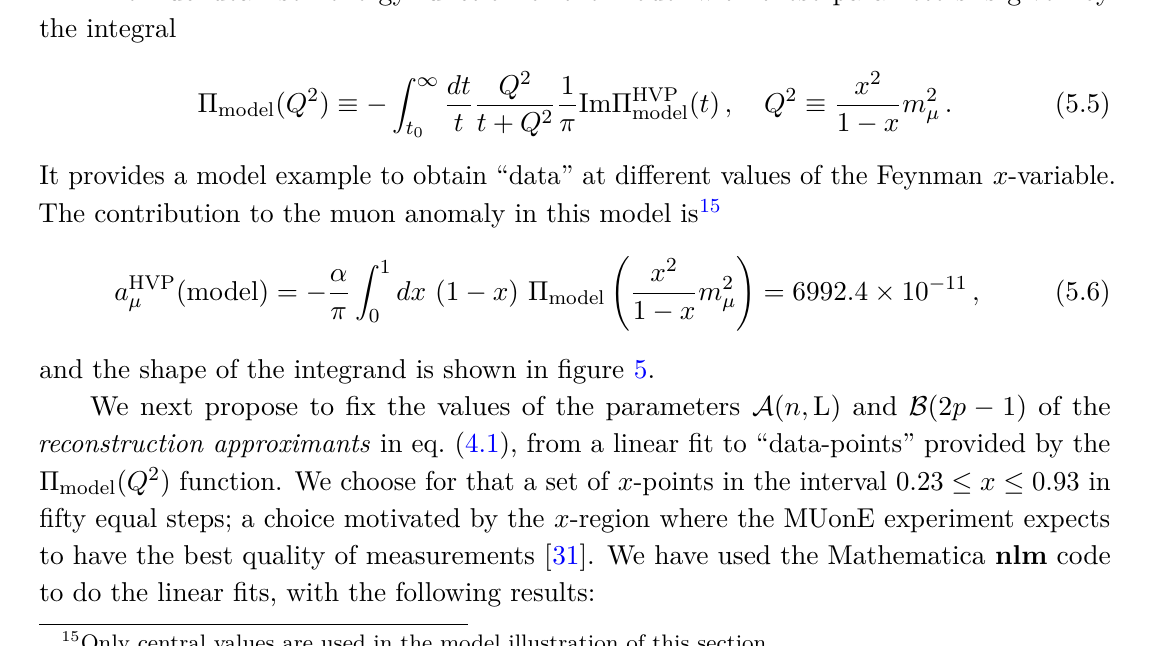
Figure 5 . Plot of the Euclidean integrand in eq. (5.6) for t c = 1 GeV 2 and ∆ = 0 . 5 GeV 2 in α